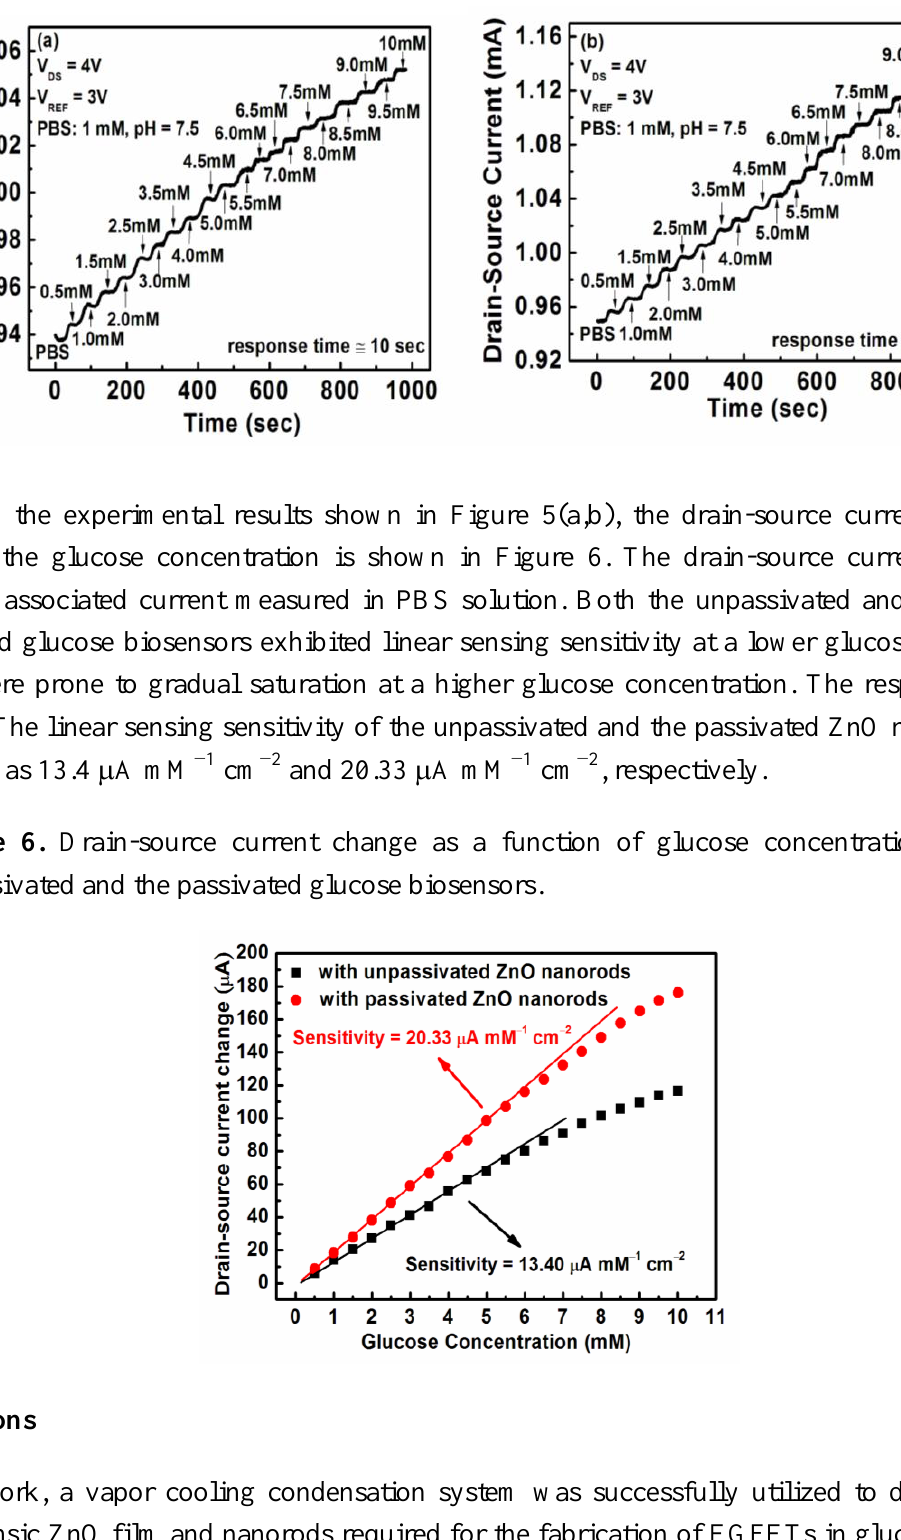
Figure 5. Drain-source current response of (a) the unpassivated ZnO nanorod glucose biosensors and (b) the passivated ZnO nanorod glucose biosensors.